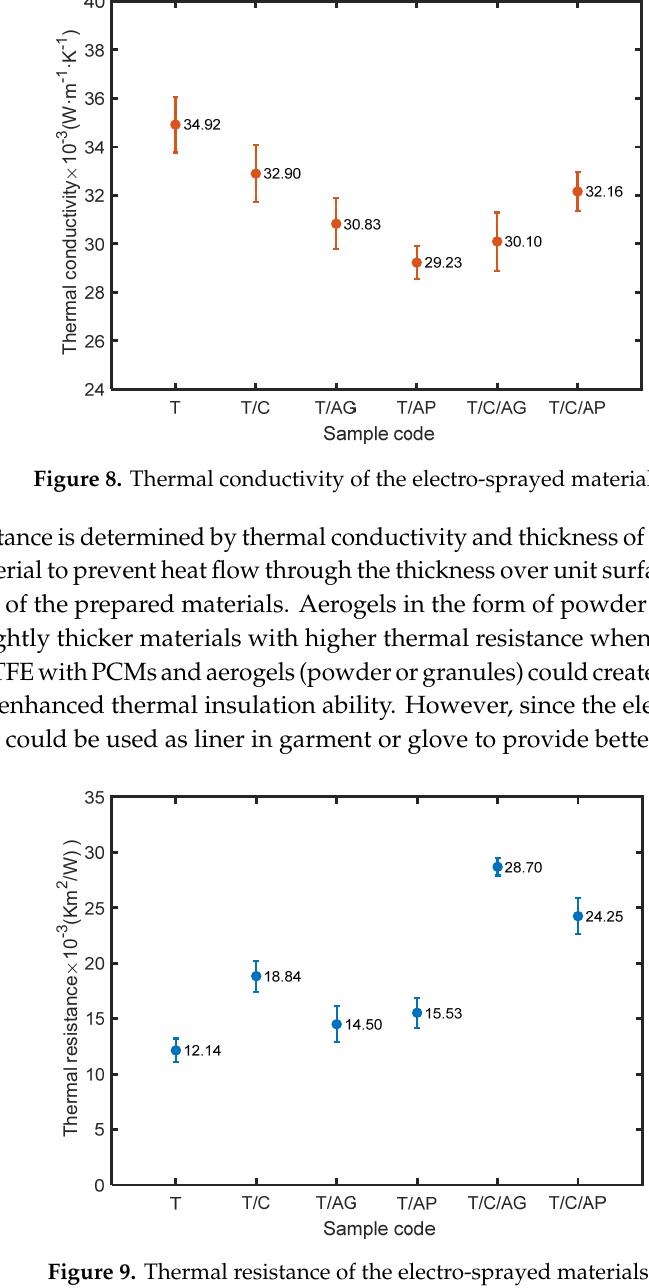
Figure 9. Thermal resistance of the electro-sprayed materials.